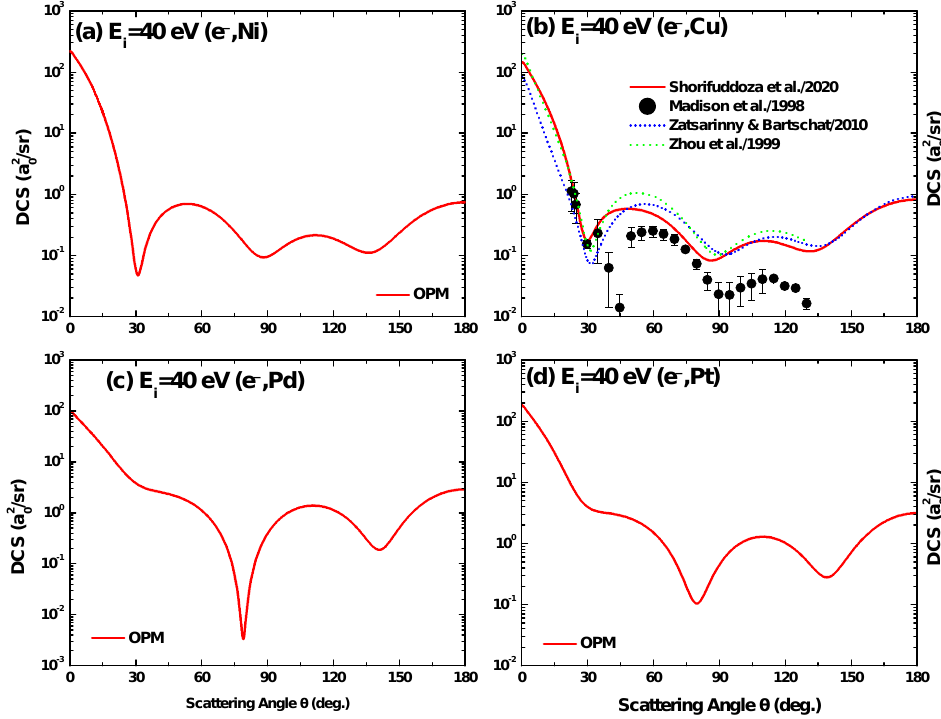
Figure 6. Angular dependence of the differential cross-sections for 40 eV electron scattering from ( a ) Ni 58 , ( b ) Cu 63 , ( c ) Pd 108 , and ( d ) Pt 196 . Experiment: Madison el al. [36]. Theory: OPM (——–), Zatsarinny and Bartschat [16] and Zhou et al.